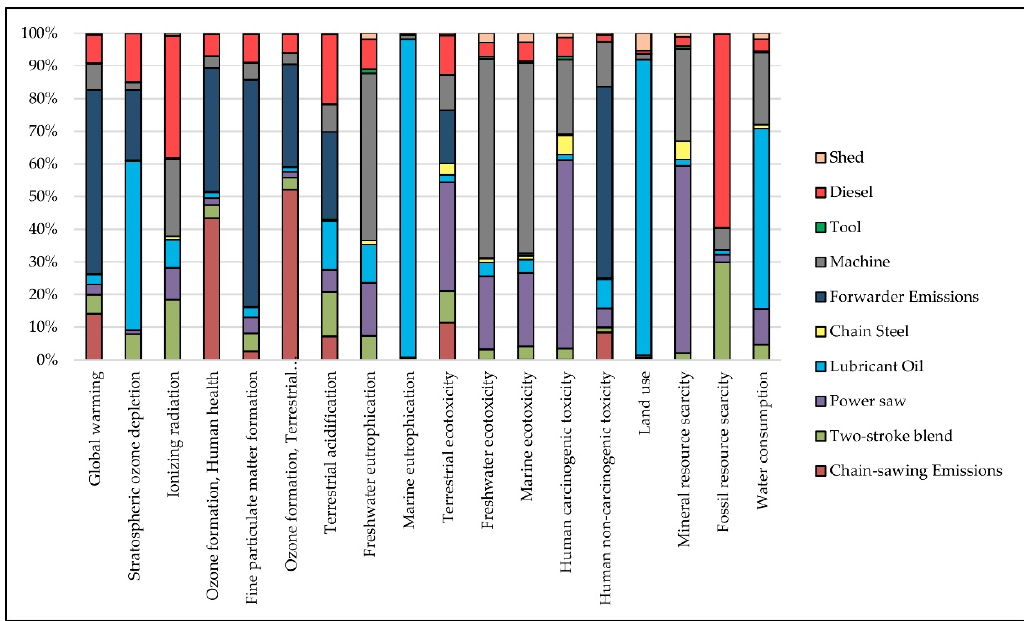
Figure 9. Contribution analysis related to scenario (ii), grapple skidder.